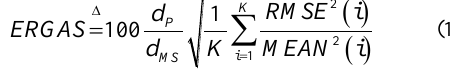
Figure 2. The fused images with different methods of GF-2 image over the water body. From left to right, up and down: MS; PAN; GS; NND; UNB and the proposed method.